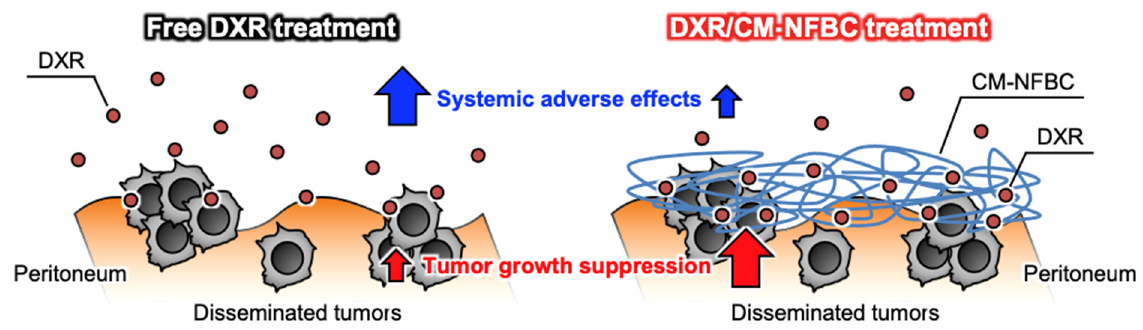
Figure 4. Schematic diagram of free DXR and DXR/CM-NFBC after intraperitoneal injection into a peritoneally disseminated tumor-xenograft mouse model.